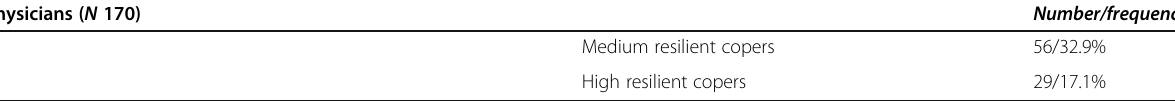
Table 3 Demographics and clinical characteristics of the physicians (Continued) Physicians ( N 170)